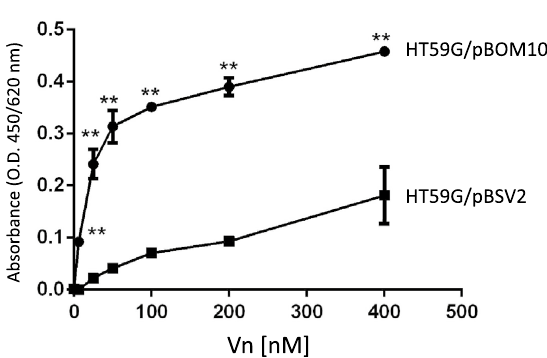
Figure 5. Vn-binding to B. garinii transformants using recombinant Vn. Vn-binding to B. garinii HT59G/ BOM1093 was quantified by ELISA and depicted as the ratio of O.D. 450 nm to the background absorbance at 620 nm. Recombinant human Vn (6.25–400 nM) was used for this study. Values are means ± SD of three independent experiments. Values were compared and analyzed between B. garinii HT59G/BOM1093 and B. garinii HT59G/BOM1093. ** p value (≤ 0.001) was calculated by Student’s t